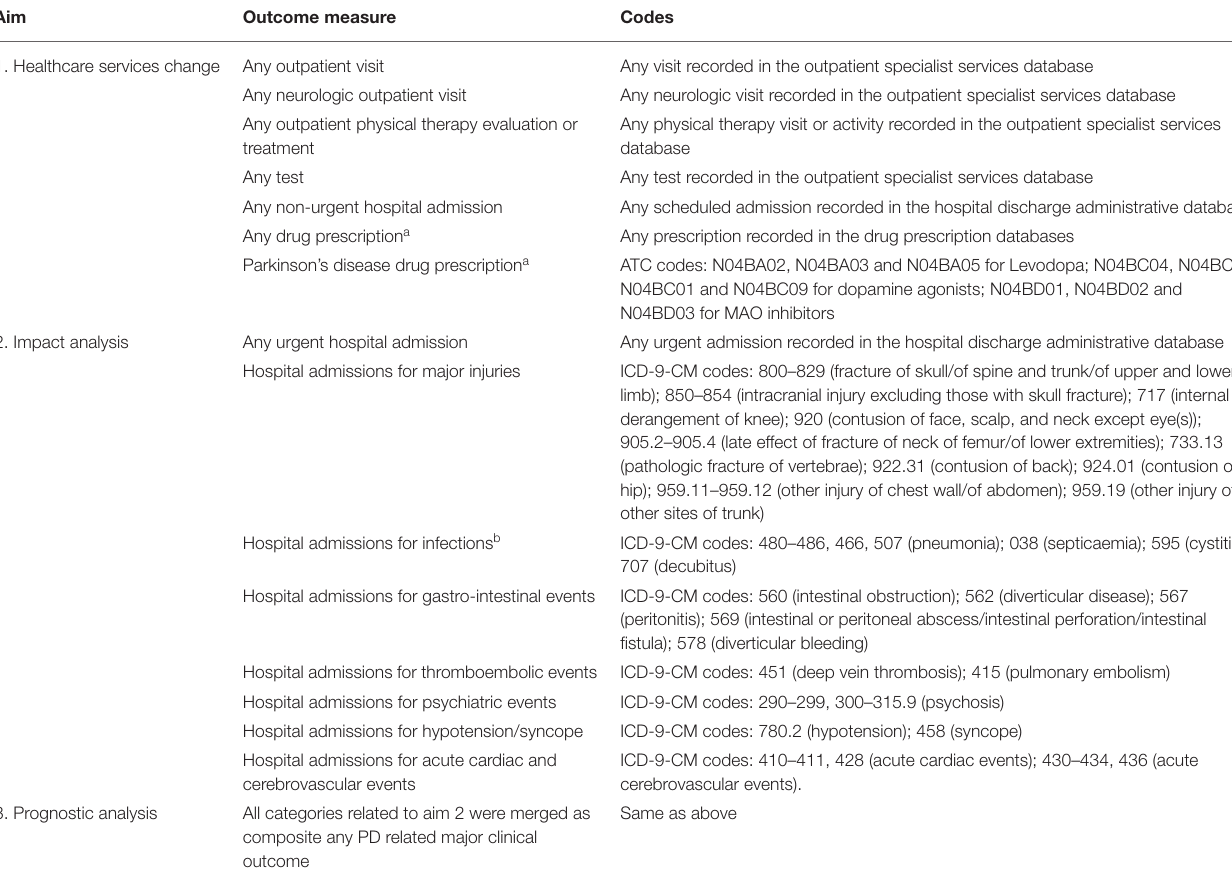
TABLE 1 | Outcome measures and corresponding codes of identification for each aim.